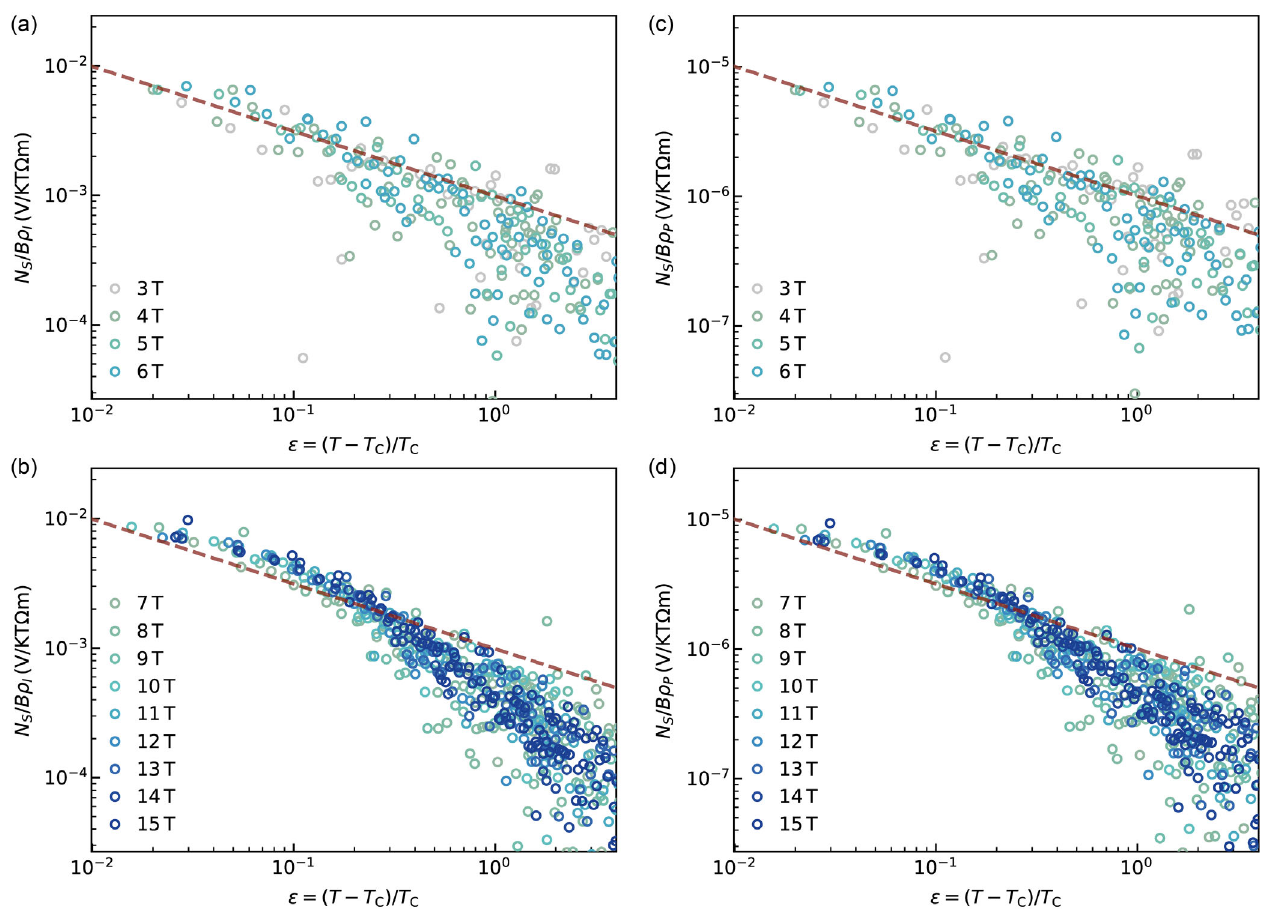
FIG. 10. Ratio of the Nernst signal and the resistivity. Same as Figs. 5(a) and 5(b), but divided by the intrinsic resistivity ρ I of the sample (a,b) or the powder resistivity ρ P